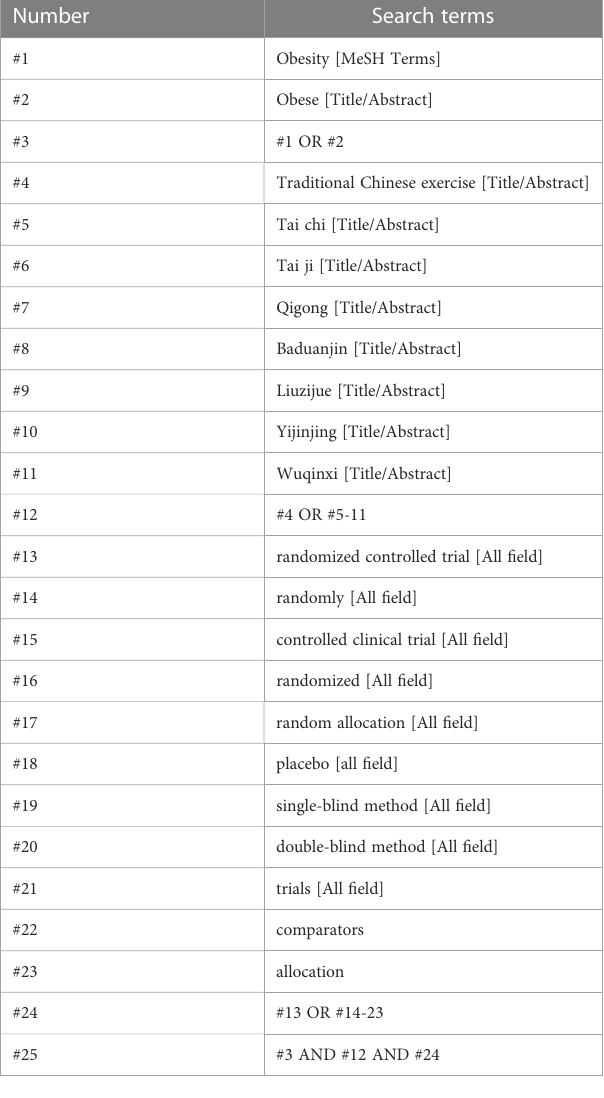
TABLE 1 Search strategy in PubMed